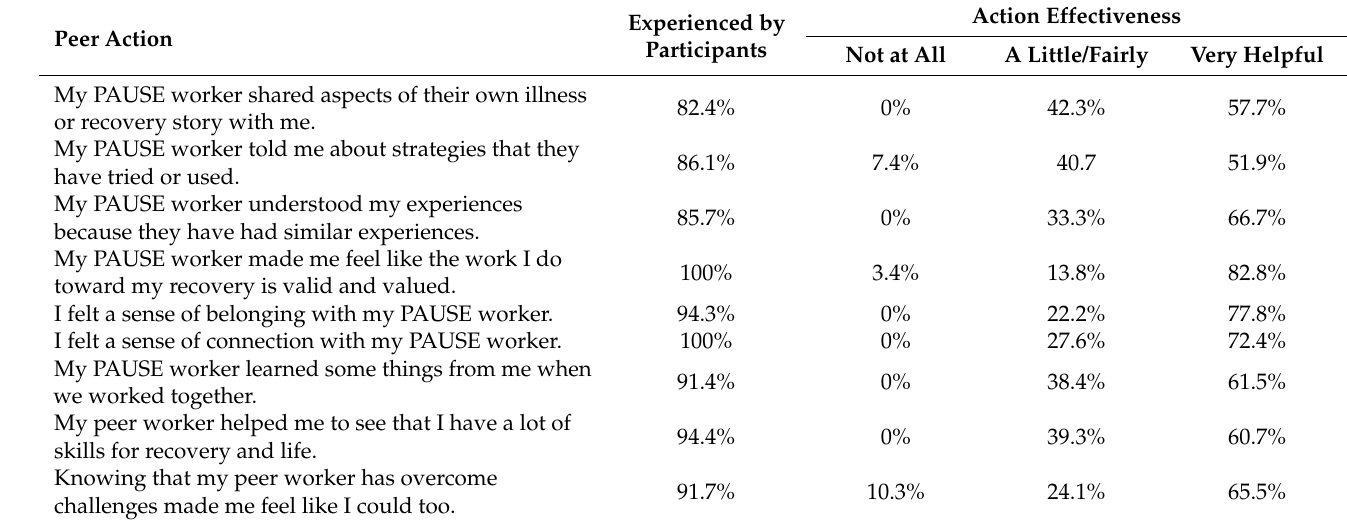
Table 4. Peer skills or techniques experienced by